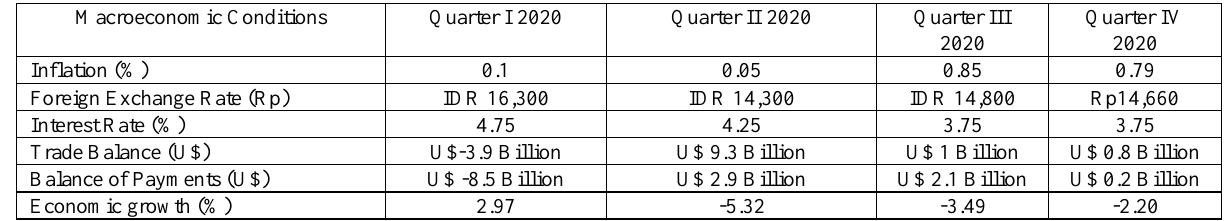
Table 1. Indonesia's Economic